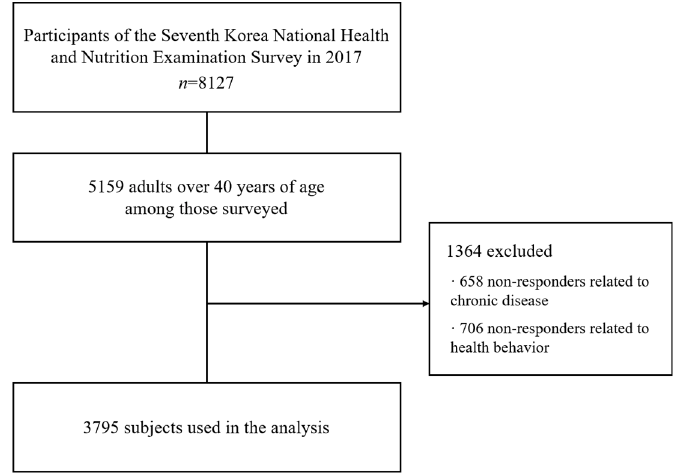
Figure 1. Flowchart of the study.